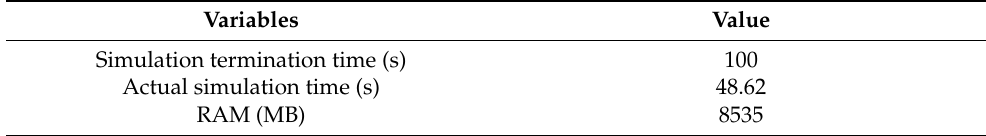
Table 5. Statistics of the complexity of the model under driving scenario 3.